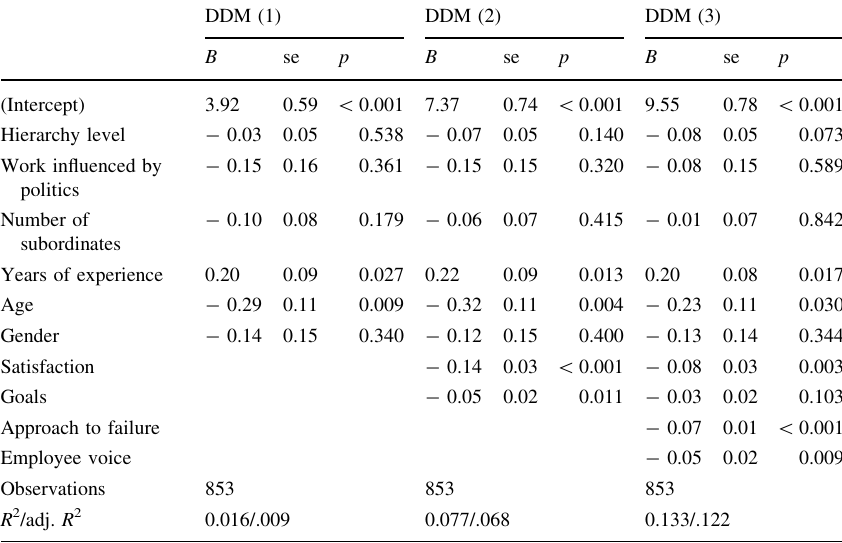
Table 3 OLS regression with defensive decision making (DDM) as dependent